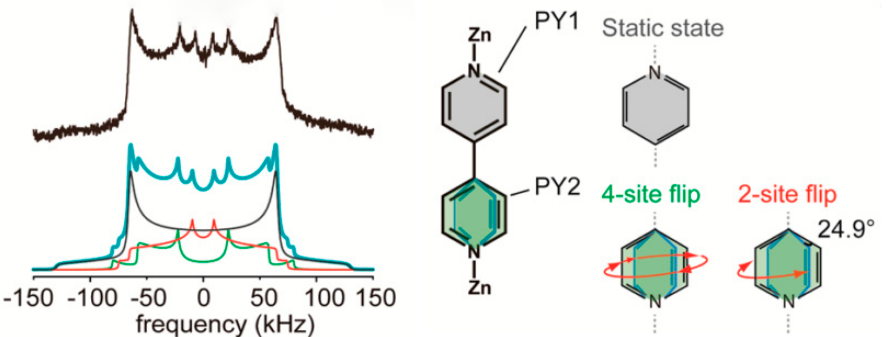
Figure 17. Experimental (top spectrum) and simulated (bottom spectra) 2 H NMR line shapes. The corresponding models for each of the three rotational situations are shown on the right-hand side. Reproduced with permission from [32]. Copyright American Chemical Society,